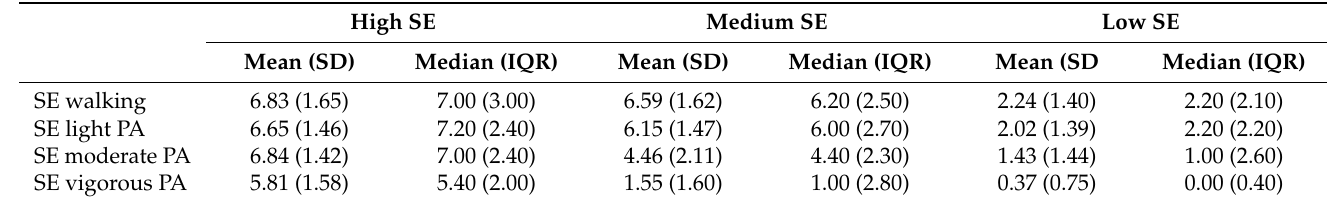
Table 4. Self-efficacy values for the three groups from the cluster analysis.